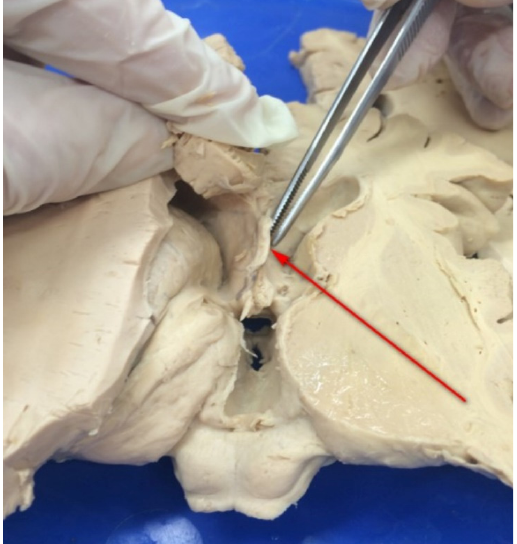
Figure 2. Brain specimen fixed in formaldehyde. Image courtesy of the Department of Descriptive and Clinical Anatomy, Center for Biostructure Research, Medical University of Warsaw. The arrowhead shows fused laminae of the septum pellucidum.